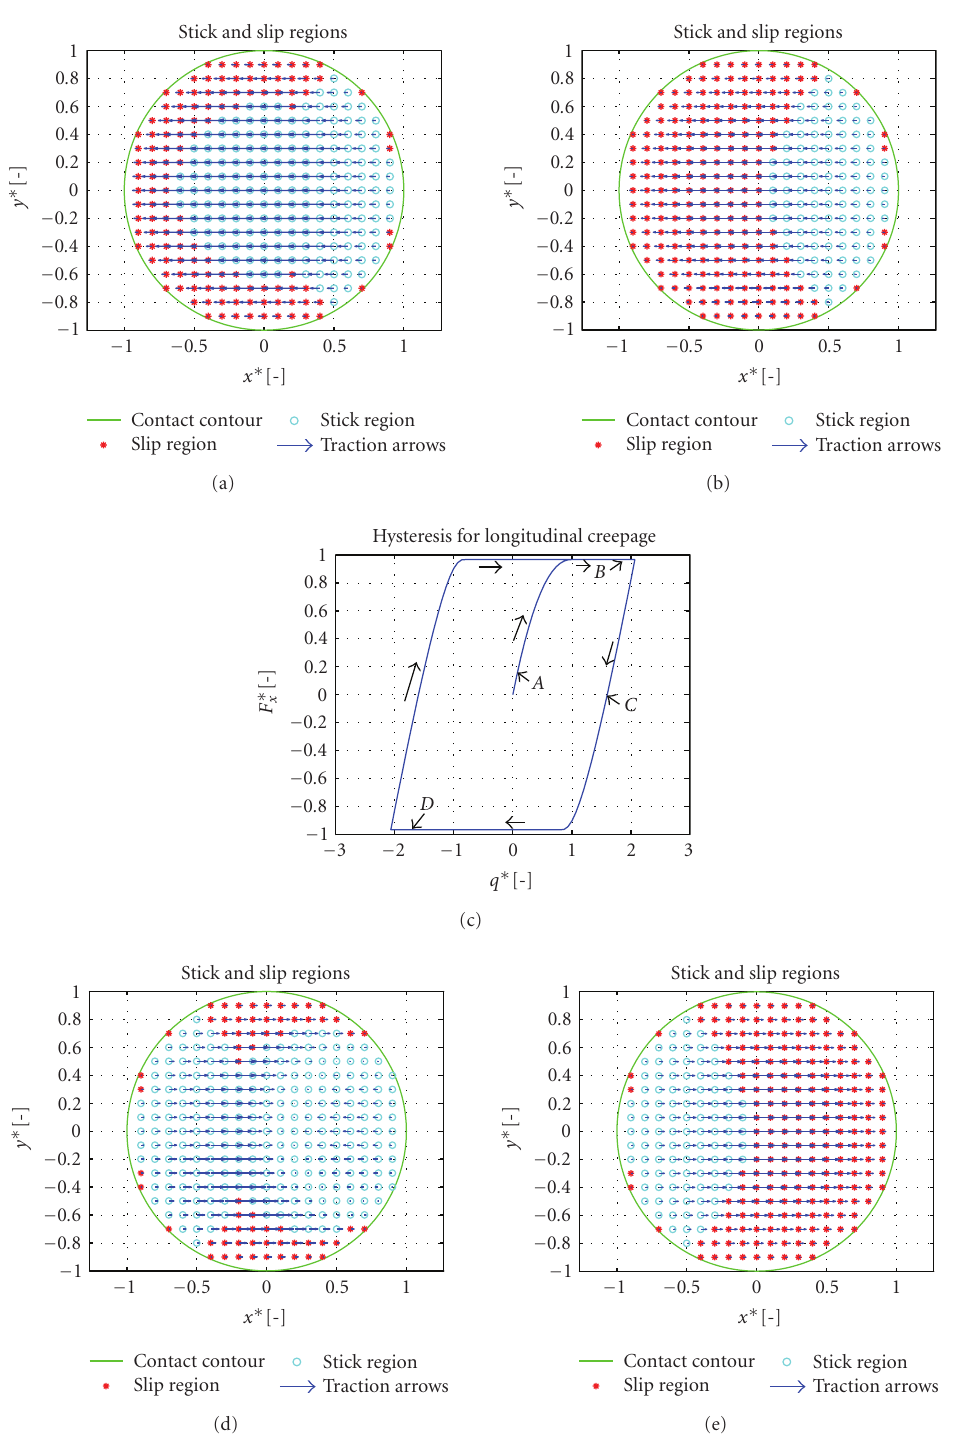
Figure 10: The results for transient (pre-)rolling with longitudinal creepage. In the middle, the hysteresis with around it, transient traction fields at selected points in the